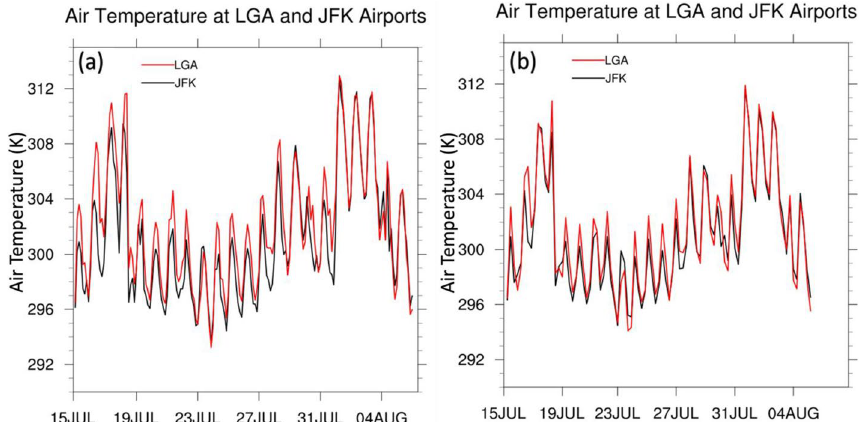
Fig. 2 a 2 m-air temperature at JFK airport (black line) and LaGuardia airport (red line) from WRF model simulations at 3 km grid spacing ( b ) Same as ( a ) but for 15 km grid spacing. The time series is from 15 July 2006 to 6 Aug